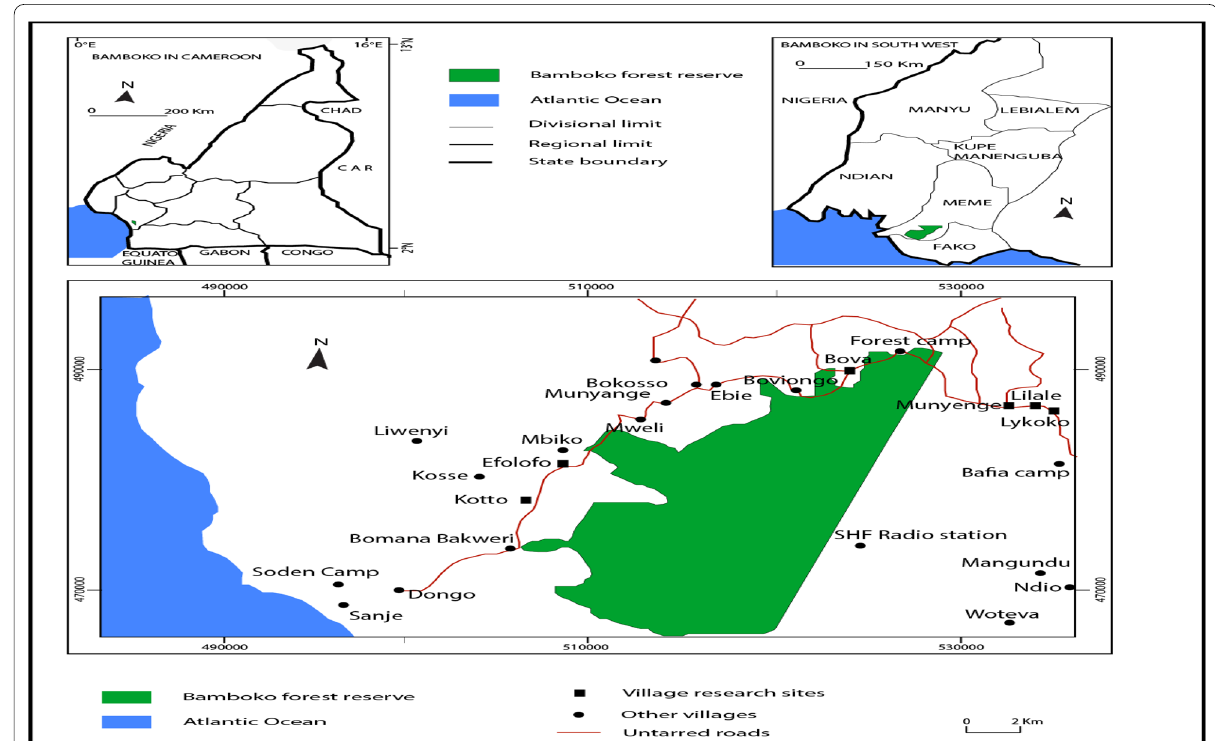
Fig. 1 Layout map of the Study area ( Source: World Resource Institute,